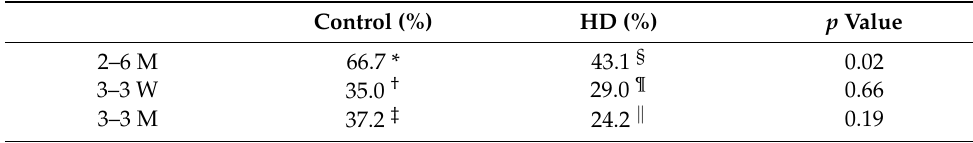
Table 3. Negative T-SPOT results for